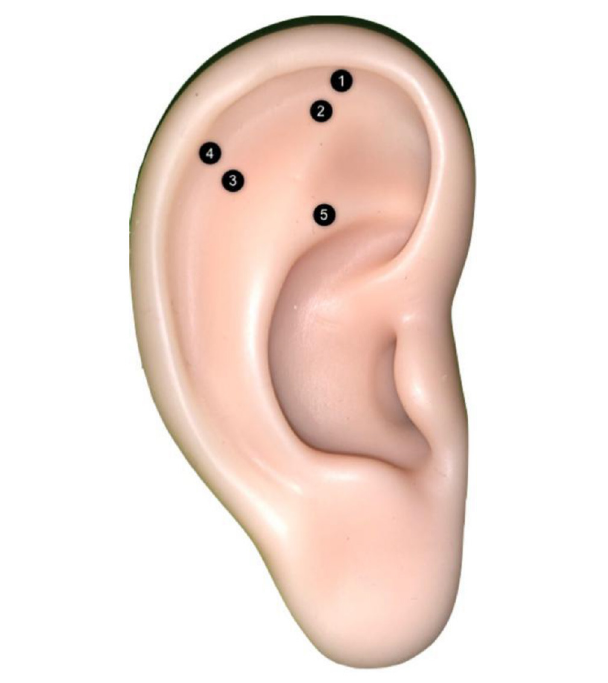
FIGURE 2 | The anxiety-reducing auricular acupressure points are used for APT. 1. Sympathetic point (MA-AH7), 2. Sanjiao point (MA-IC4), 3. Heart point (MA-IC), 4. Shenmen point (MA-TF1), and 5. Adrenal gland point (MA-TG).